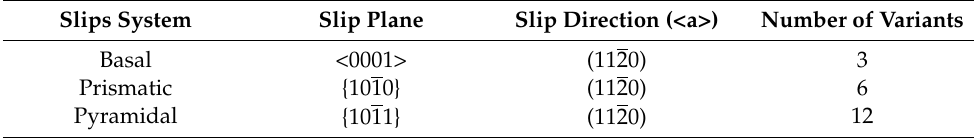
Table 2. The number of α (cid:48) / α -titanium slip systems analysed in this